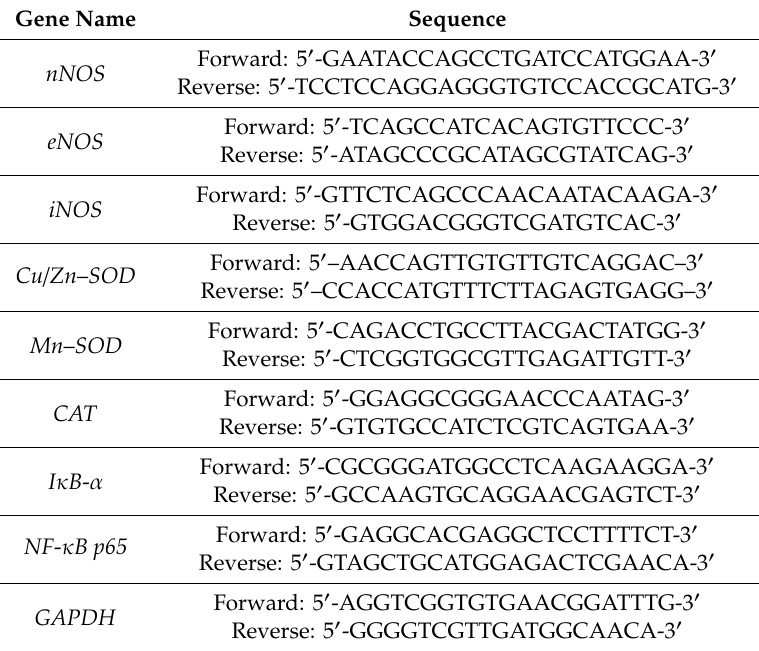
Table 1. Sequences of the primers used for the mice liver